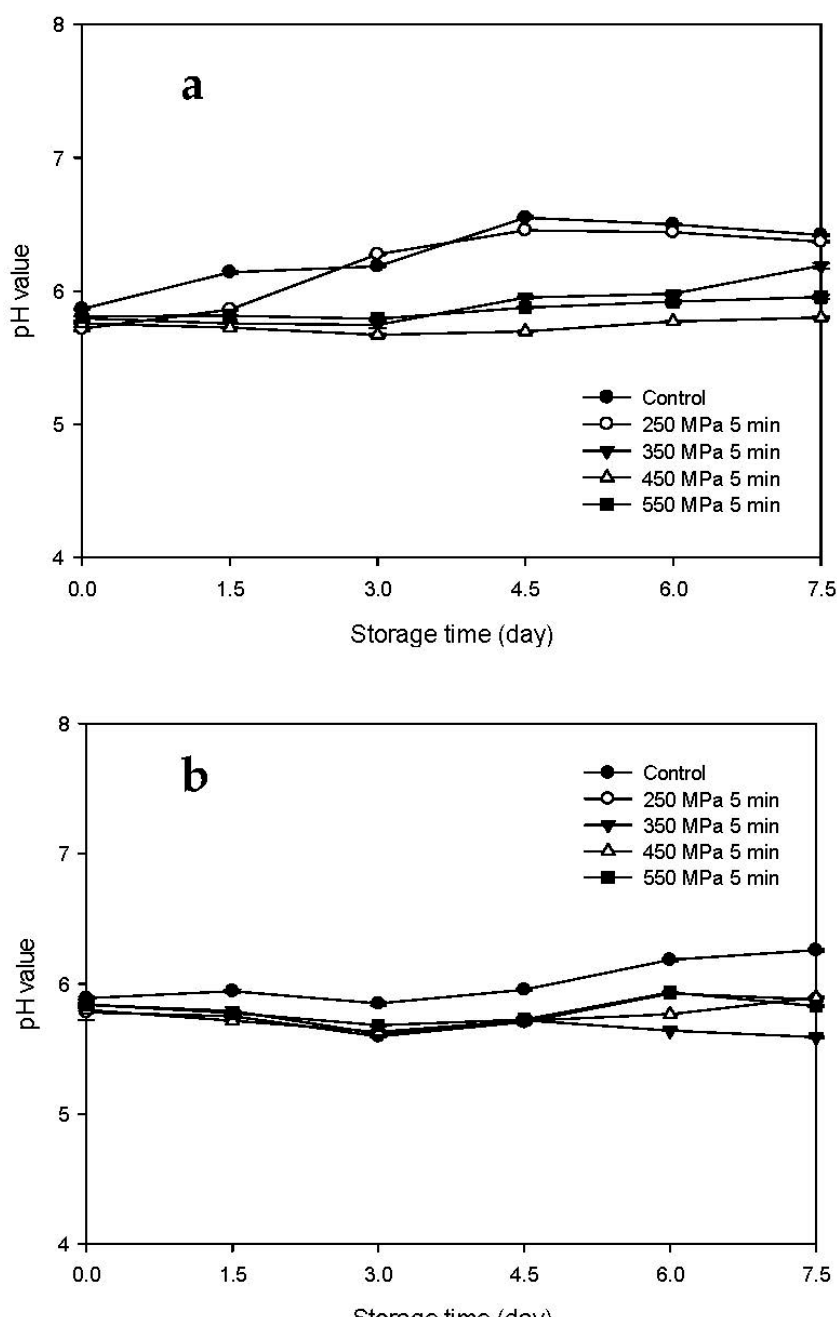
Figure 3. Changes in pH of tuna meat samples inoculated with ( a ) Morganella morganii and ( b ) Photobacterium phosphoreum after high-pressure processing treatment at 250, 350, 450, and 550 MPa for 5 min during storage at 15 °C.